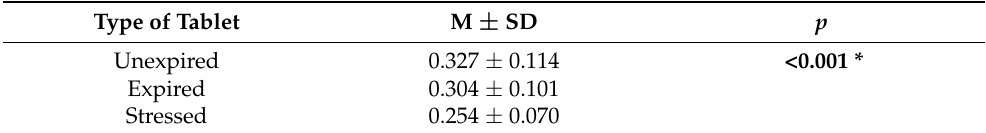
Table 6. The differences between the maximum and minimum reflectances of the analyzed tablets containing